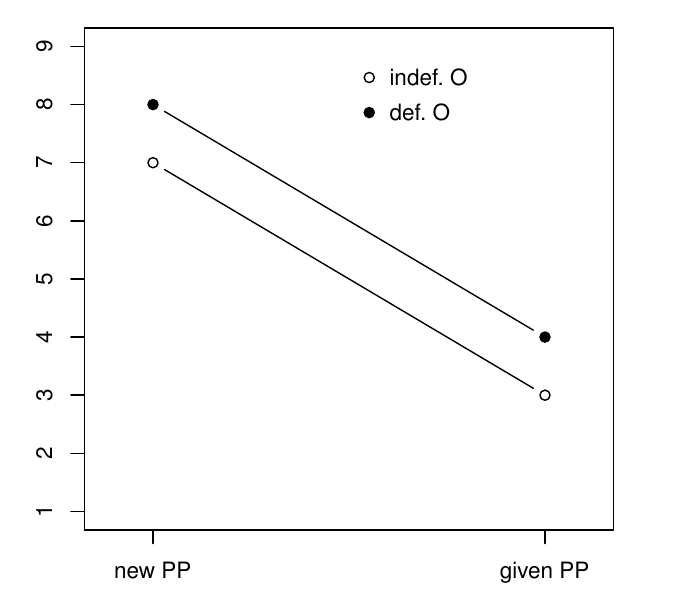
Figure 4 Plot of medians for experiment 2